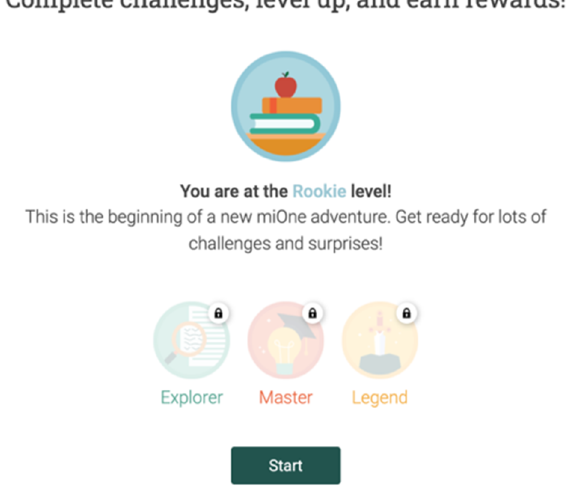
Figure 5. Initial modal with information about the various levels (Authors’ copyright).